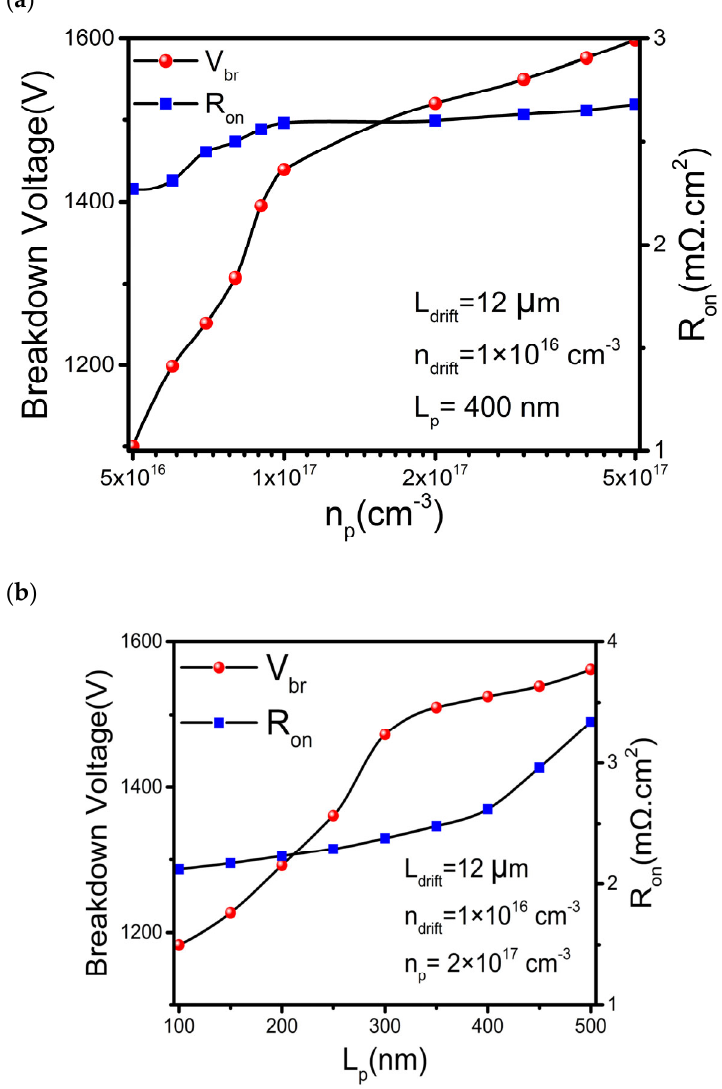
Figure 6. Optimization of V br with respect to ( a ) p-doping concentration (n p ) and ( b ) P-layer thickness (Lp).